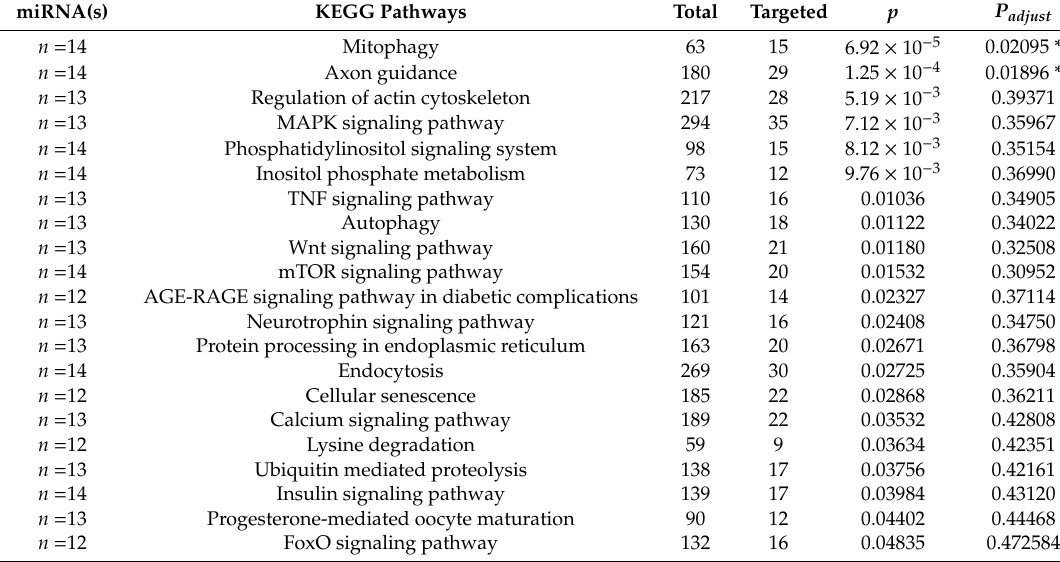
Table 3. KEGG pathways enriched by genes targeted by the 14 candidate miRNAs (cancer pathways are not included).